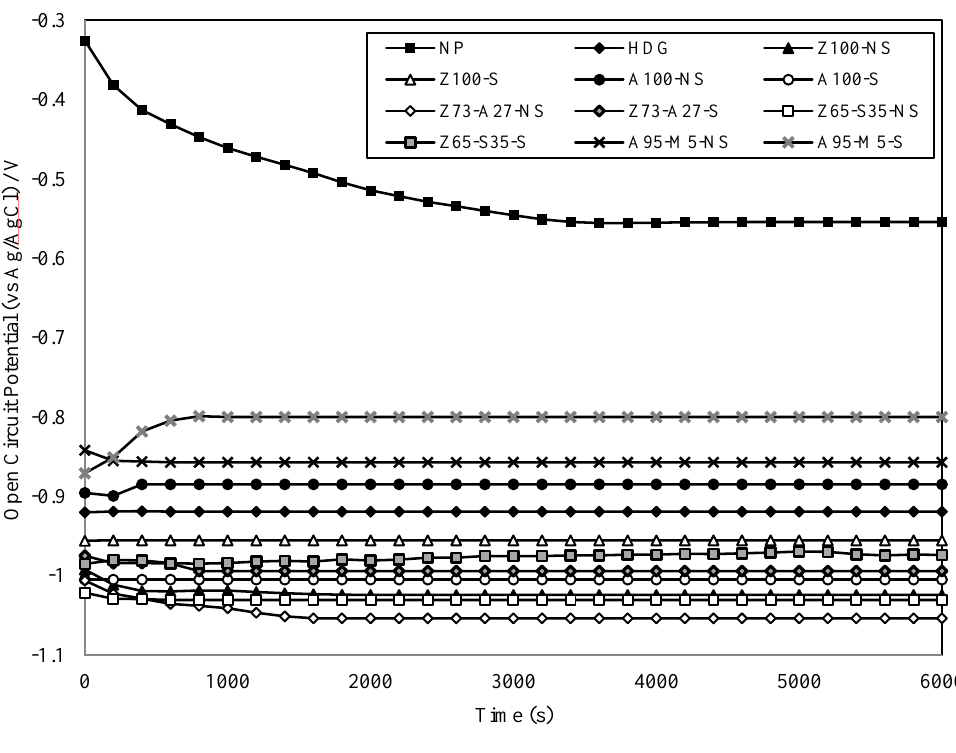
Figure 3. Relationship between open circuit potential and time.